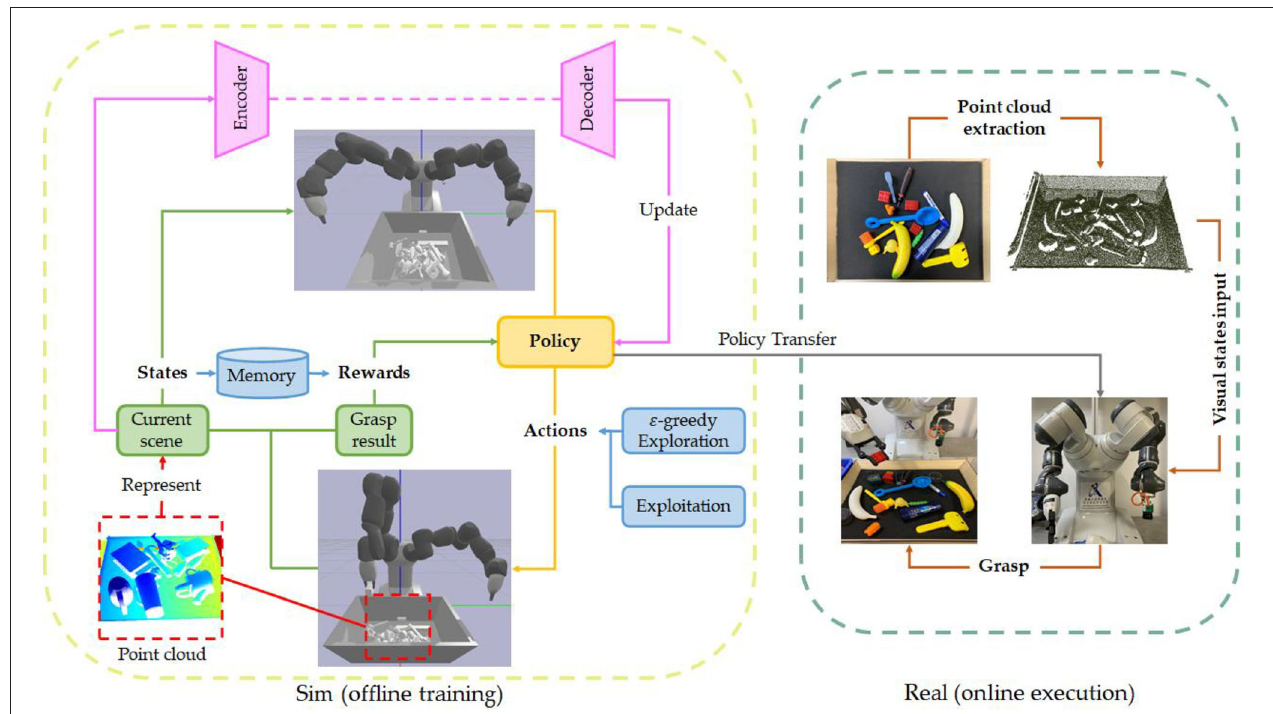
FIGURE 7 | The deep reinforcement learning framework of robotic grasp learning based on point cloud. In order to reduce the cost of trial and error, the current robot grasping based on reinforcement learning is to first train the model in a simulation environment and then migrate to the real robot (Sim to